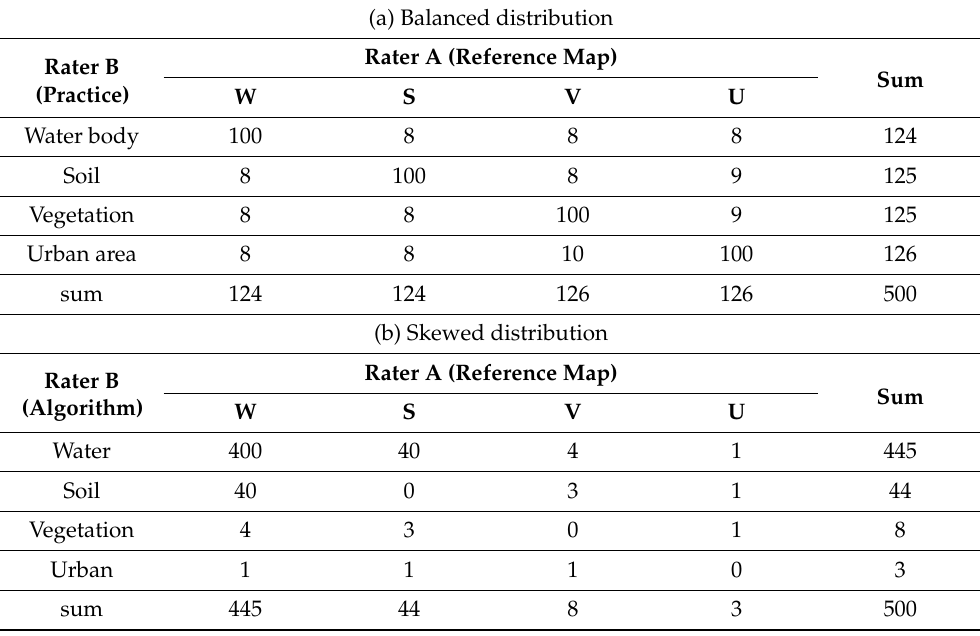
Table 3. Tables illustrating a confusion matrix with a balanced (a) and a skewed (b)